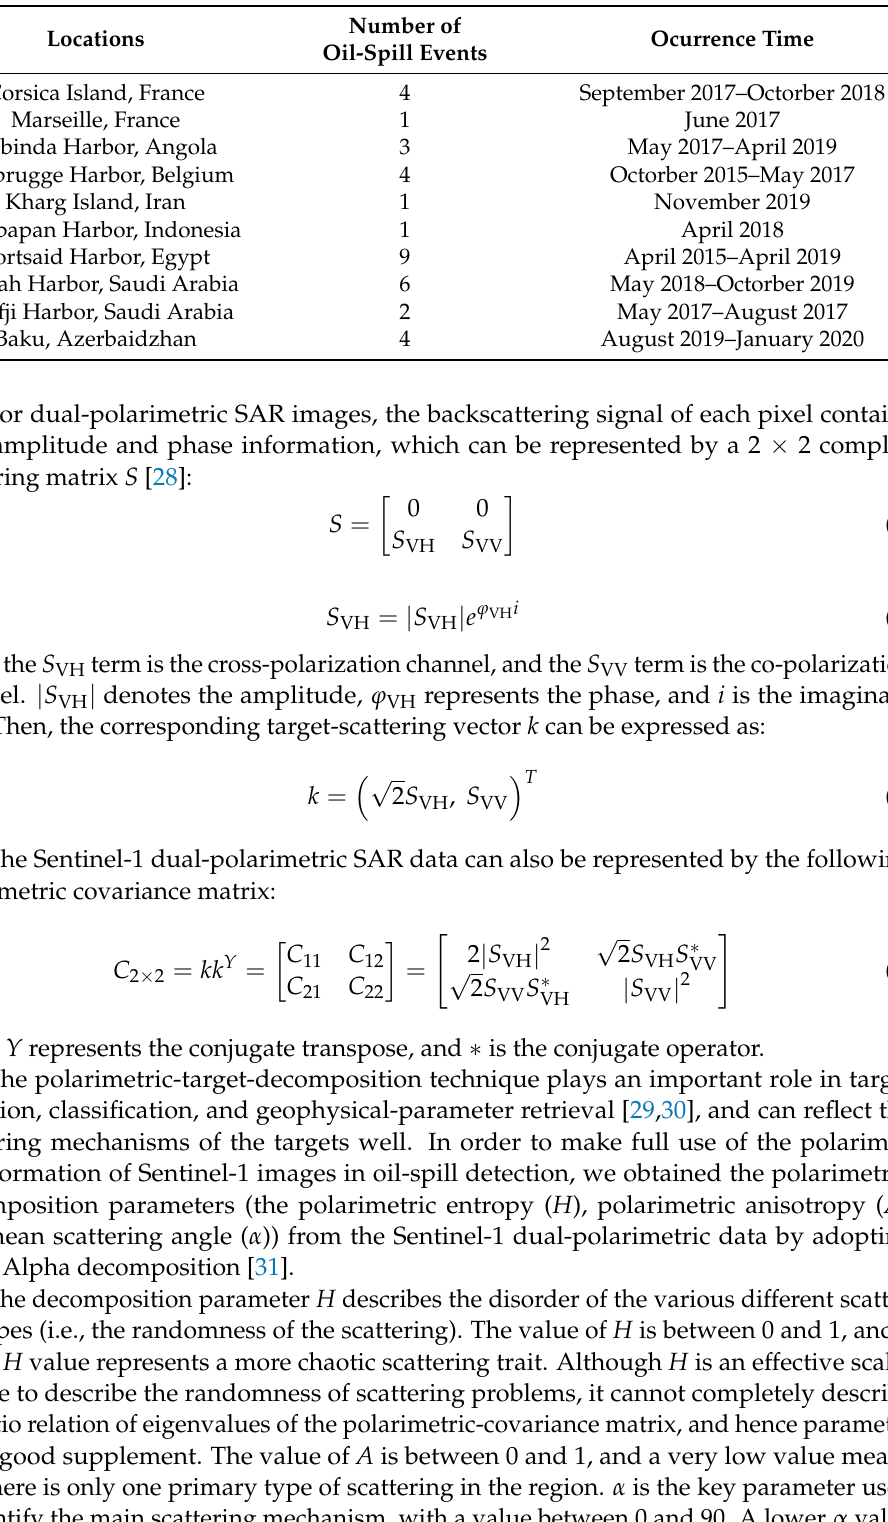
Table 2. Some detailed information of the oil-spill